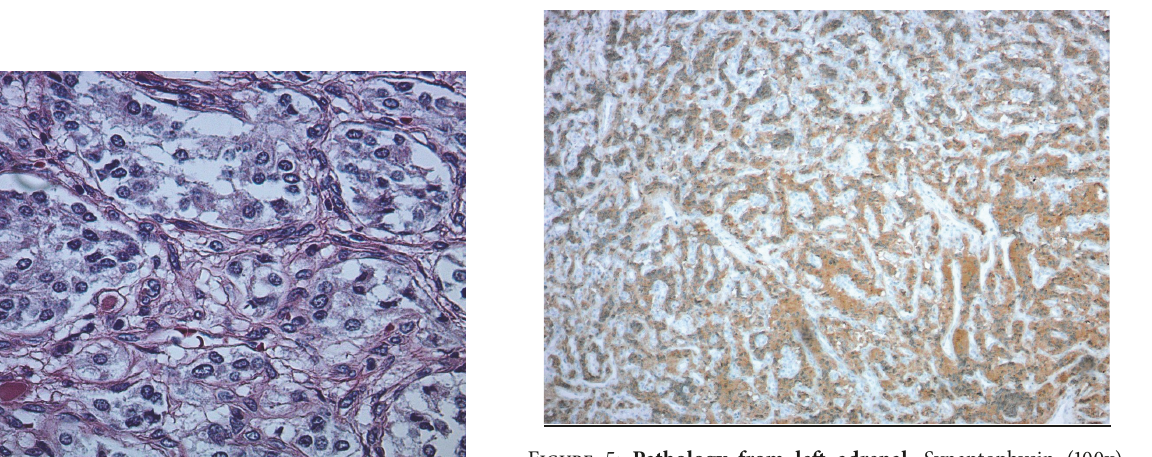
Figure 5: Pathology from left adrenal. Synaptophysin (100x). Cytoplasmic granular staining diffusely positive in tumor